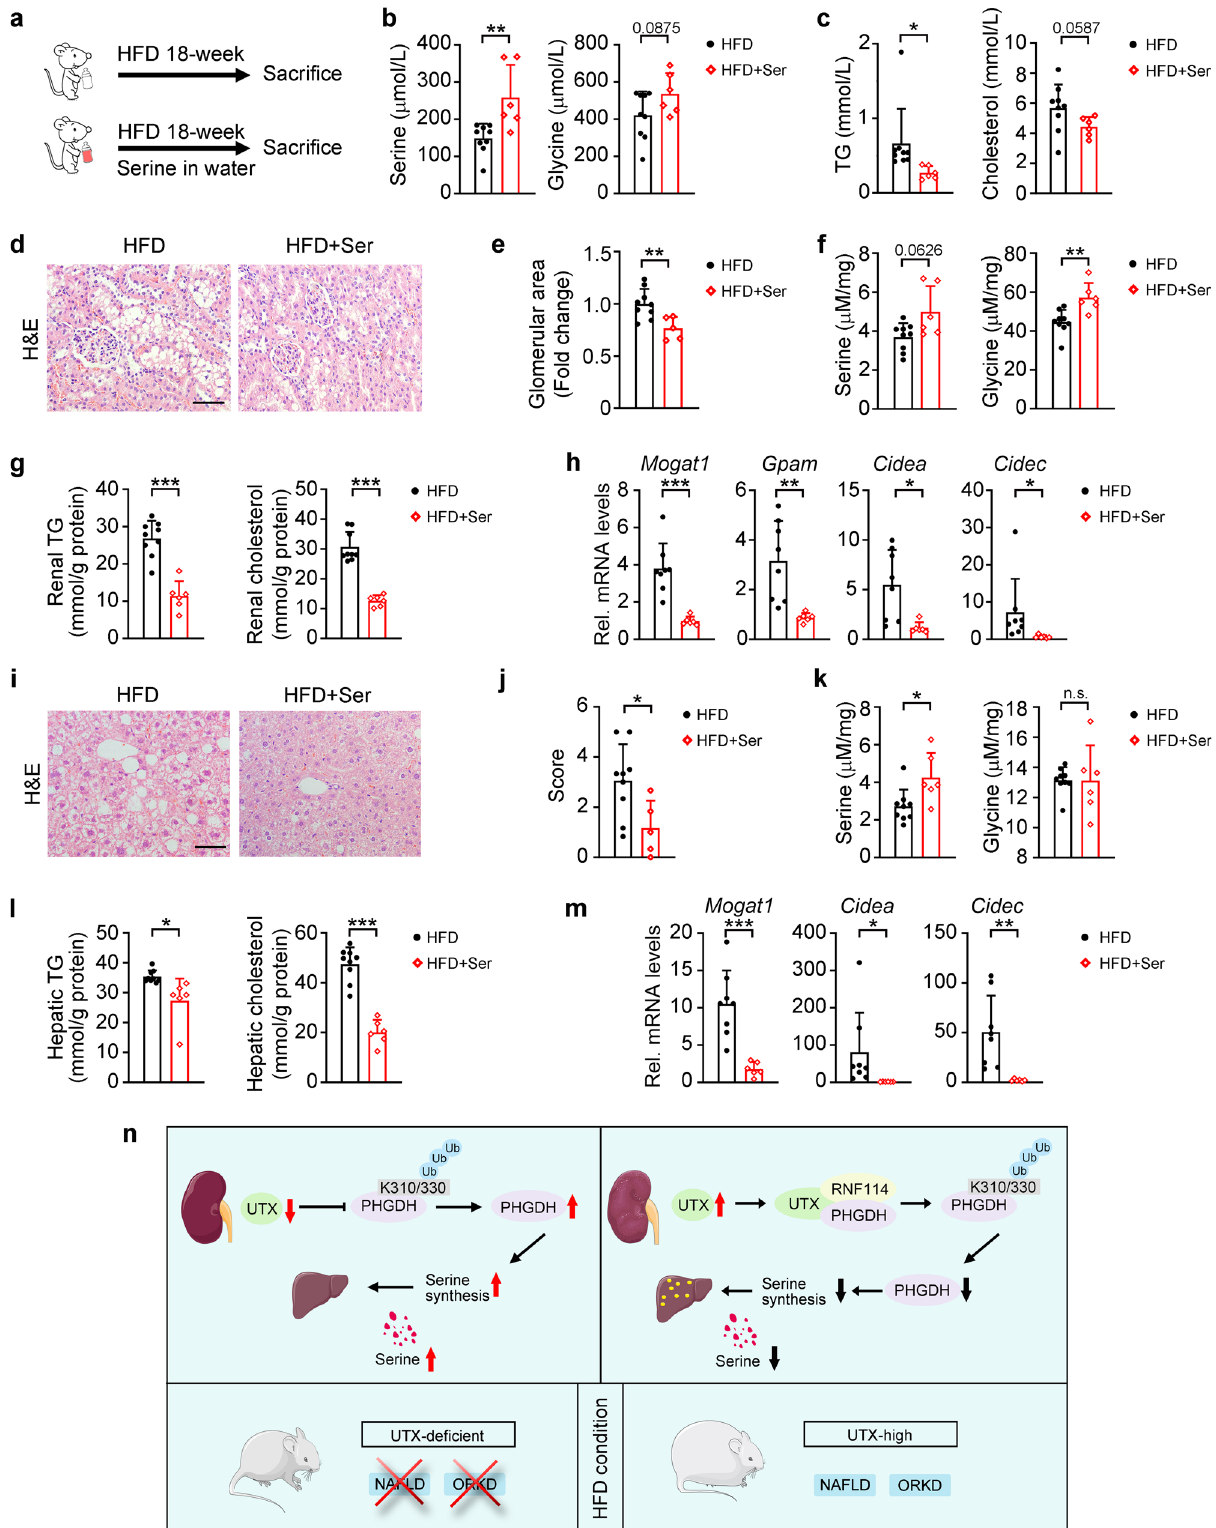
pGL3-basic-CIDEC plasmids were constructed with standard procedures (the TTGGTGC-3' or 5'-ACCGAAAGCAGAACCTTAGCAAAG-3'), RNF114 (5'-CA primers used are provided in Supplementary Table 9). CCGGCCGCTTACACGTGTCCGCA-3'), ASCT1 (5'-CACCGTTGCAGCT Most cells were transfected with indicated plasmids for 6h, then treated with/ TTCCGTACGGTA-3'), ASCT2 (5'-CACCGCAGCGCCACACCAAAGACGA-3'), without 400 μ M PA for 48h before collection. Some cells were transfected with were used to knockout UTX, PHGDH, RNF114 or ASCT1/2, respectively. indicated plasmids for 24 h, and treated with different inhibitors (CQ, chloroquine, Expression plasmids for HA-tagged Ubi (WT, K6, K11, K27, K29, K33, K48, K63, 0.05 mM; 3-MA, 3-methyladenine, 3.35 mM; MG132, 10 μ M) for 6 h. For serine AKR) and myc-tagged UTX were constructed. HA-tagged RNF114, Flag-tagged treatments, normally cultured or PA-stressed HK-2 cells, primary mouse wildtype PHGDH and seven lysine to arginine mutants, pGL3-basic-CIDEA, NATURE COMMUNICATIONS| (2022) 13:3835